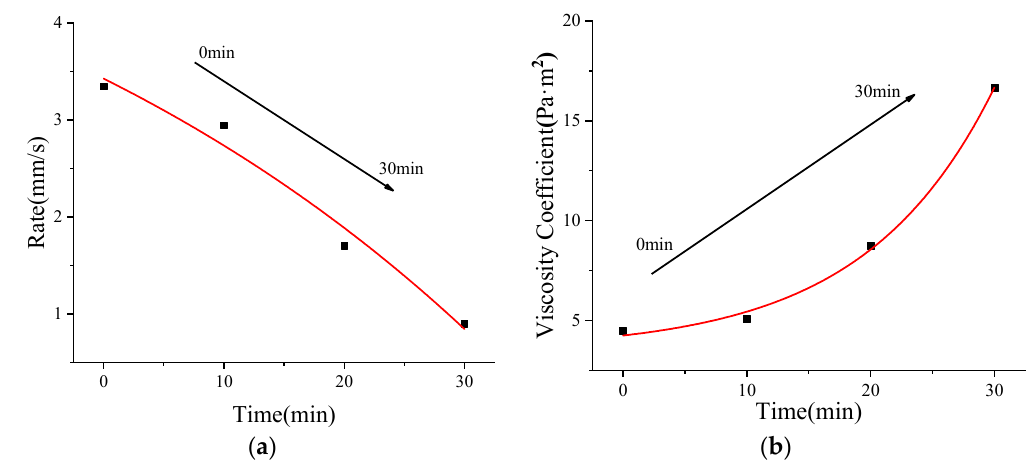
Figure 4. PDMS viscosity coefficient calculation results. ( a ) Relationship between the average velocity of the falling ball and the solidification time of the PDMS; ( b ) the relationship between the viscosity coefficient of the PDMS and its solidification time.